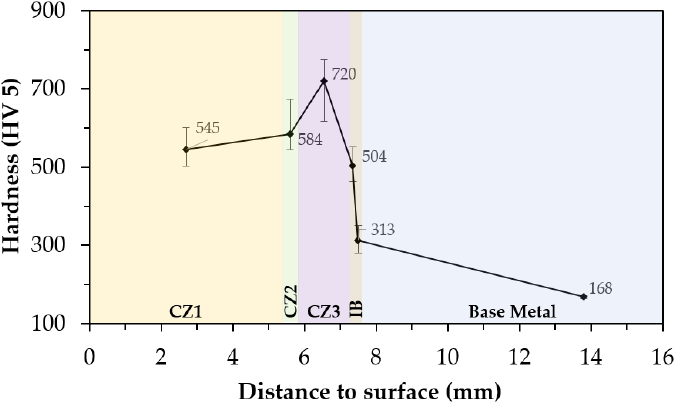
Figure 7. Hardness profile from the composite surface (CZ1) to the base metal.